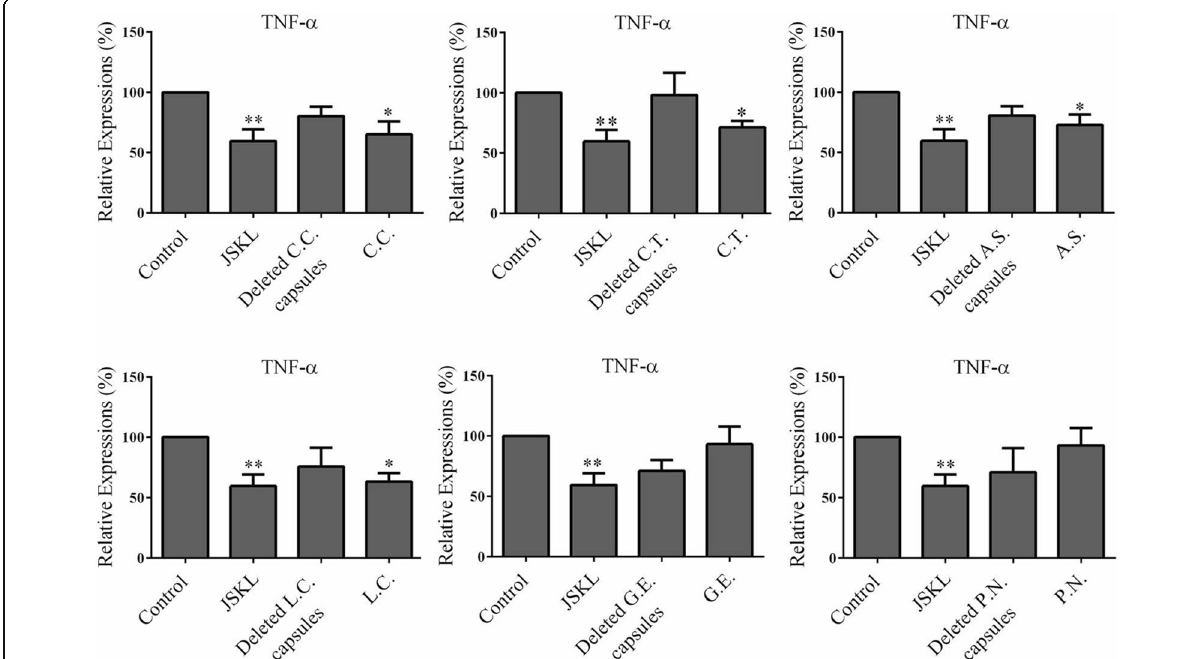
Fig. 3 Effect of JSKL, deleted-herb-capsule and single-herb-capsule on the expression of TNF- α in LPS-stimulated MH7A cells. *p < 0.05 , **p < 0.01 vs control